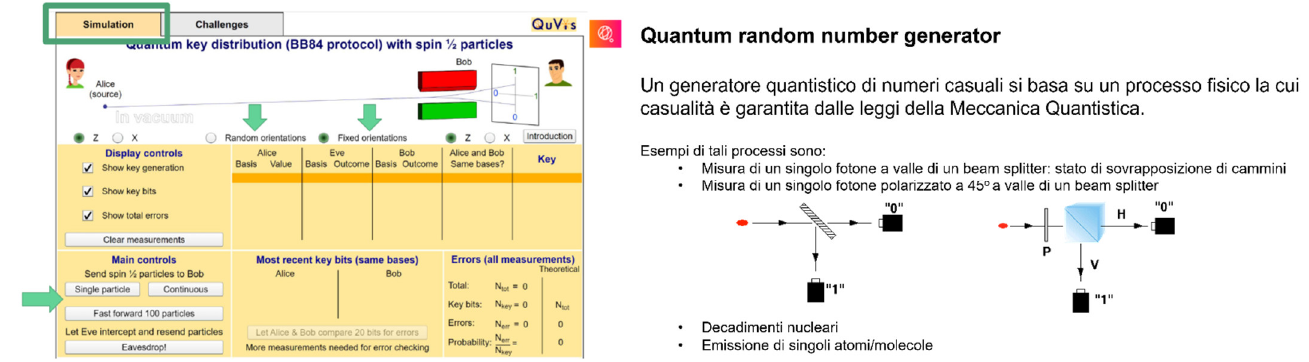
Figure A2. Examples from the specific path “Quantum information”. Left : BB84 protocol implemented on QuVis. Right : example of implementation of a random number generator with single photons.